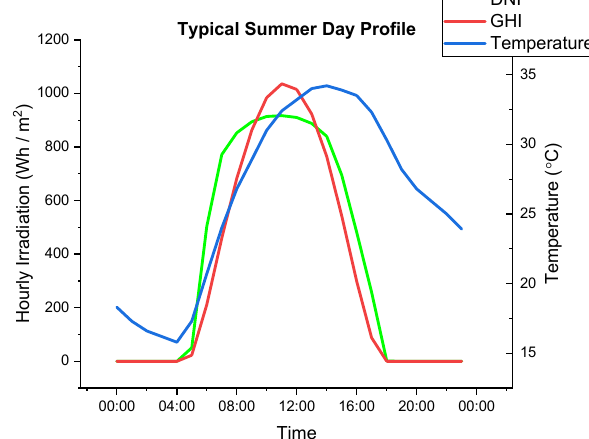
Figure 3. Typical Winter Day Profile.